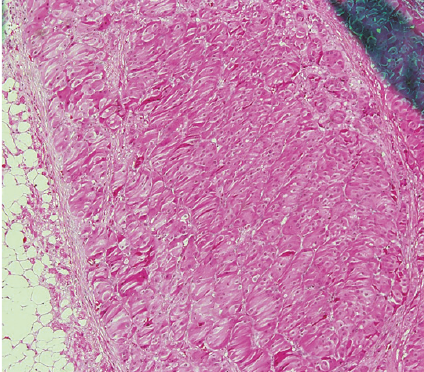
Figure 1: Hyperplastic adrenal cortex.